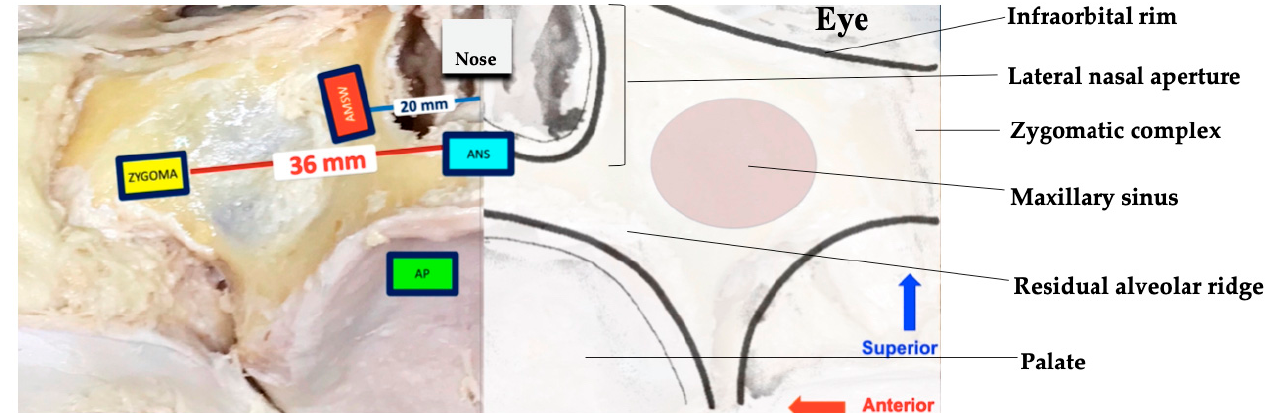
Figure 1. ( Left ) The four sites of interest in this study were the zygomatic buttress (ZYGOMA), anterior maxillary sinus wall (AMSW), anterior palate (AP), and anterior nasal spine (ANS). The location of the bone block was determined by using dental morphometrics. The average distance between the central incisor and the second premolar was approximately 36 mm, based on the mesiodistal sum teeth concerned. The average distance between central incisor and root apex of canine is approximately 20 mm. ( Right ) Anatomical scheme of the midface.